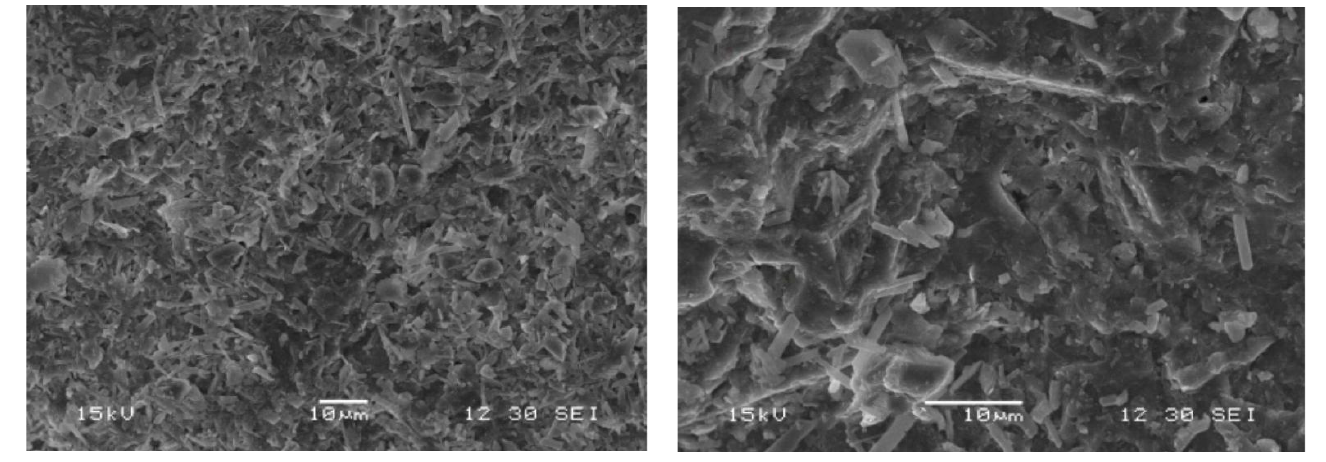
Figure 6. Fine particle scan results.